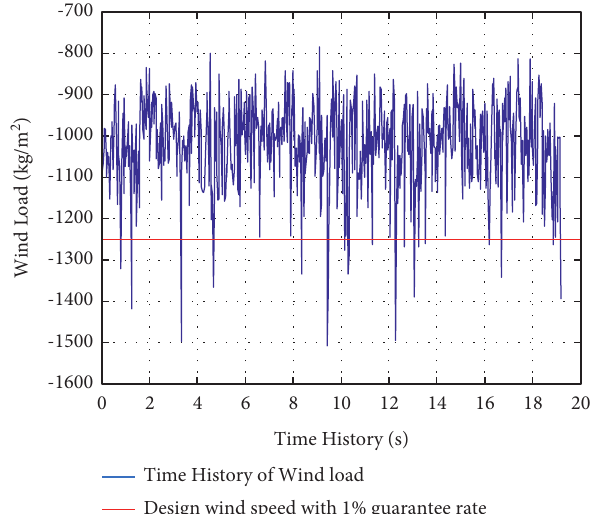
Figure 6: Most of time history are negative, or all of them are negative.